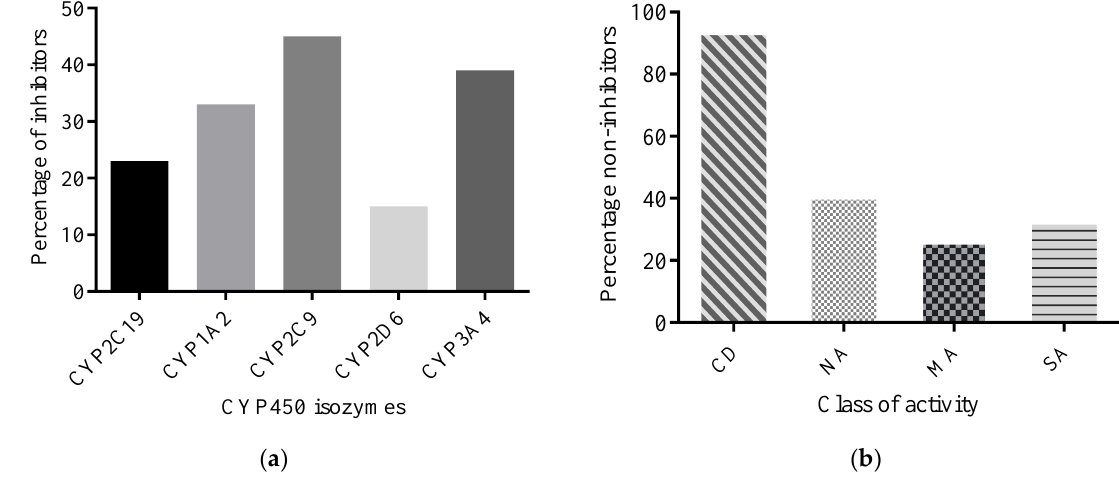
Figure 11. Percentage of AMNPs that are CYP450 isozyme inhibitors. ( a ) shows the percentage of AMNPs that are inhibitors of one or more CYP450 isozymes. ( b ) shows the percentage of the CD and AMNP categories that are non-inhibitors of CYP450 isozymes.